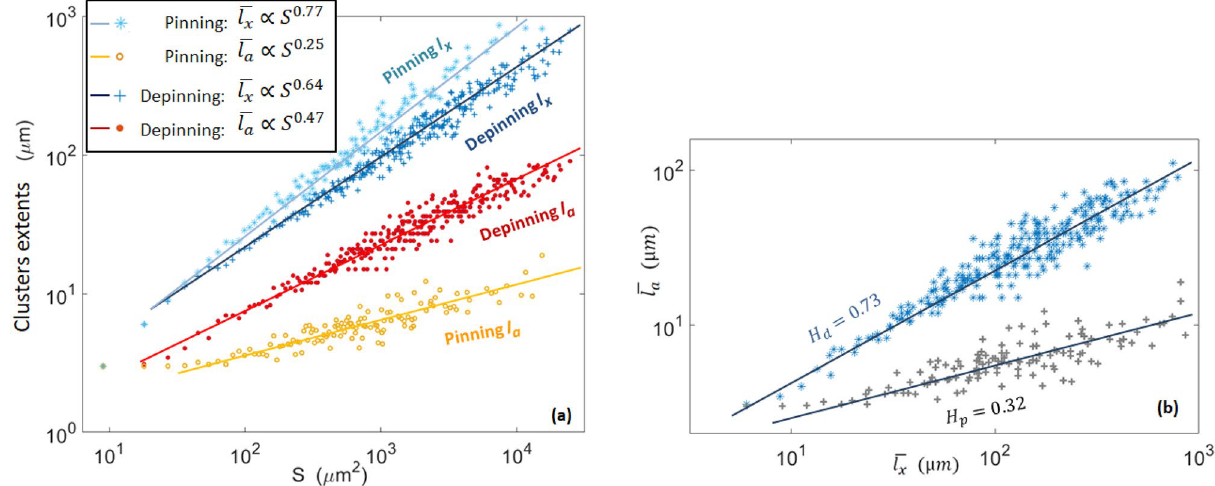
Figure 10. ( a ) Mean linear extents of the simulated pinning and depinning clusters as a function of cluster size. The four data sets are, from top to bottom, l x for the pinning clusters (hollow stars), l x for the avalanche clusters (crosses), l a for the avalanche clusters (plain points), l a for the pinning clusters (hollow points). The straight lines correspond to the fits described in the inset. See text for the equivalent experimental exponents. ( b ) Mean inline extent l a as a function of the mean crossline extent l x for the pinning and depinning clusters. The straight lines have a slope of, respectively, H p = 0.32 and H d = 0.73